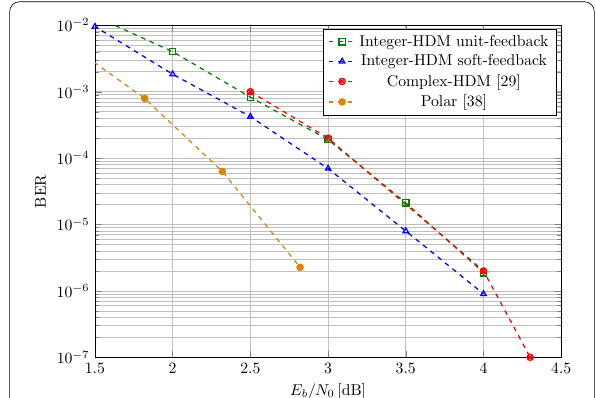
Fig. 4 Bit error rate (BER) of considered codes with k = 128 information bits and D = 512 real-valued transmission symbols